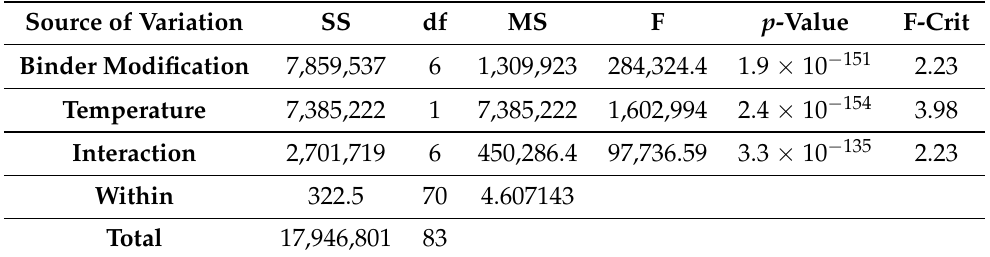
Table 4. Two-way ANOVA testing of the viscosity of neat and modified asphalt binders. Source of